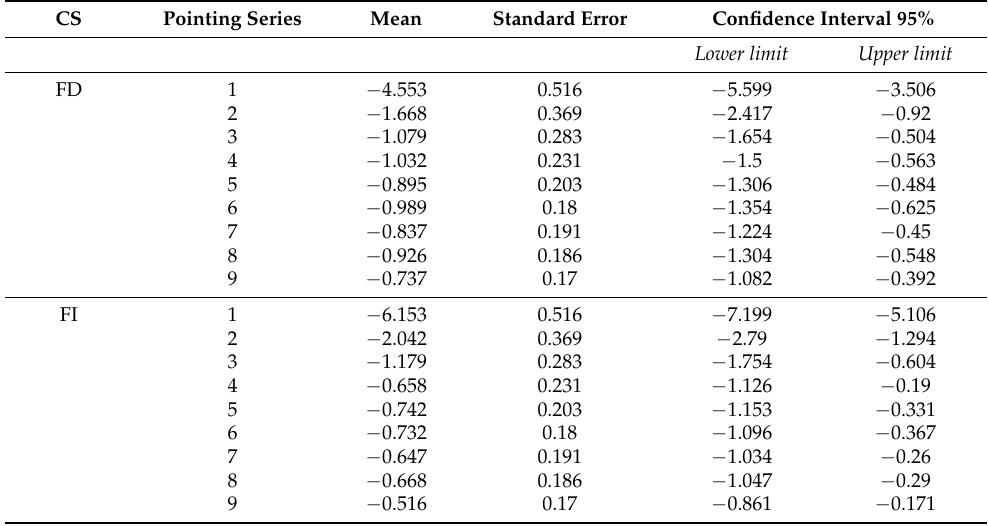
Figure 6. The graphic shows the time gradient of prismatic adaptation (t AP ) means ( ± SE) in the nine sets of visible pointing (VP) for field dependent (FD) and field independent (FI). Table 1. The table summarizes descriptive statistics of the time gradient of prismatic adaptation (t PA ) by cognitive style (CS) and pointing series for the visible pointing condition. FD = Field dependent; FI = Field